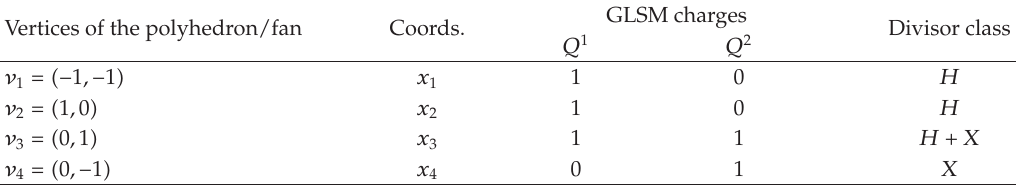
Table 1: Toric data for the del Pezzo-1